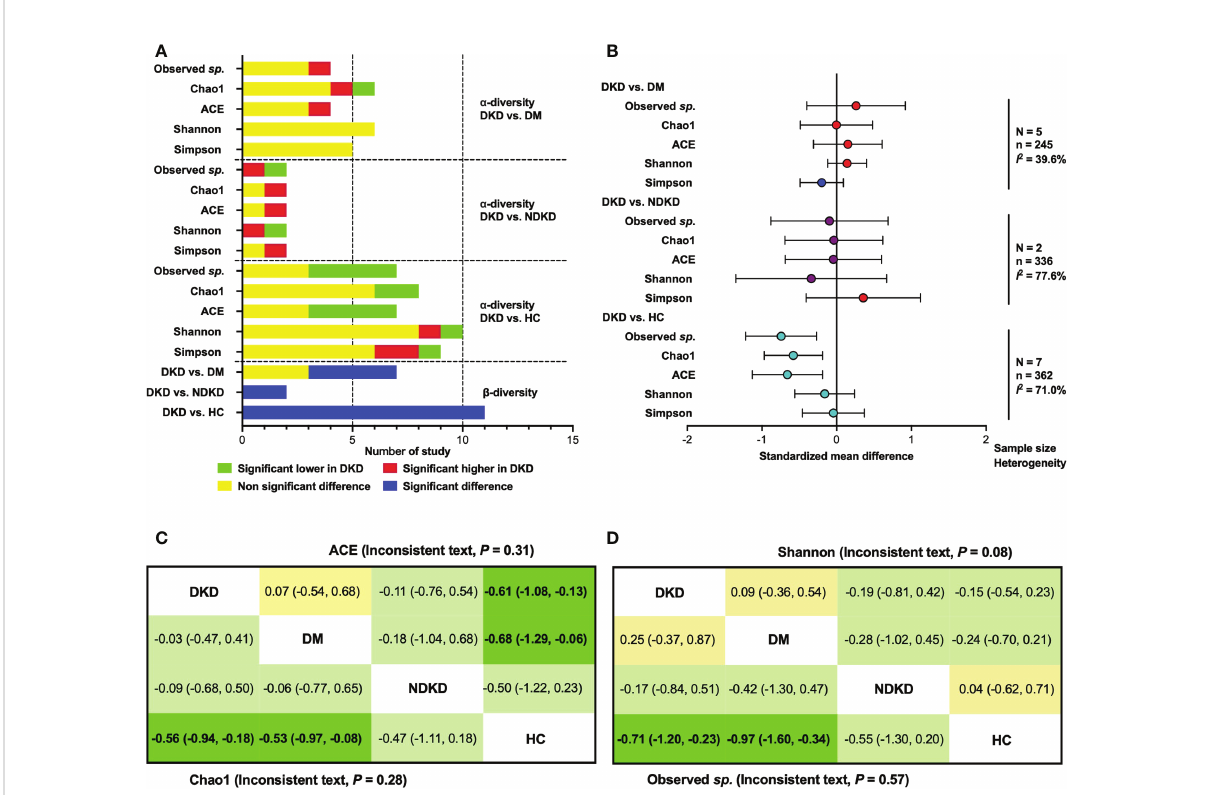
FIGURE 1 Qualitative analysis and meta-analysis for a - and b -diversity. (A) Qualitative comparisons for a - and b - diversity; (B) Meta-analysis for a -diversity indices. (C) Network meta-analysis for ACE and Chao1 index; (D) Network meta-analysis for Observed sp. and Shannon index. Data are shown as standardized mean difference (95% con fi dence interval). The estimate is for the column-de fi ning treatment compared to the row-de fi ning treatment. Statistical signi fi cance is de fi ned as 95% CIs that do not overlap zero (bold text). DKD, diabetic kidney disease; DM, diabetes mellitus; HC, healthy controls; NDKD, non-diabetic kidney disease; N, number of